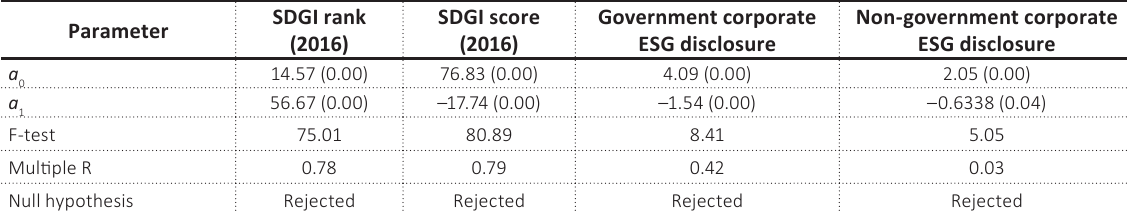
Table C4. OLS with dummy variables of the differences between developed countries and emerging countries SDGI Parameter